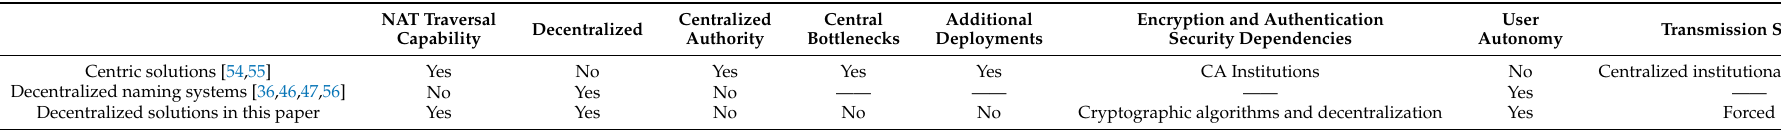
Table 3. A comparison of three types of solutions